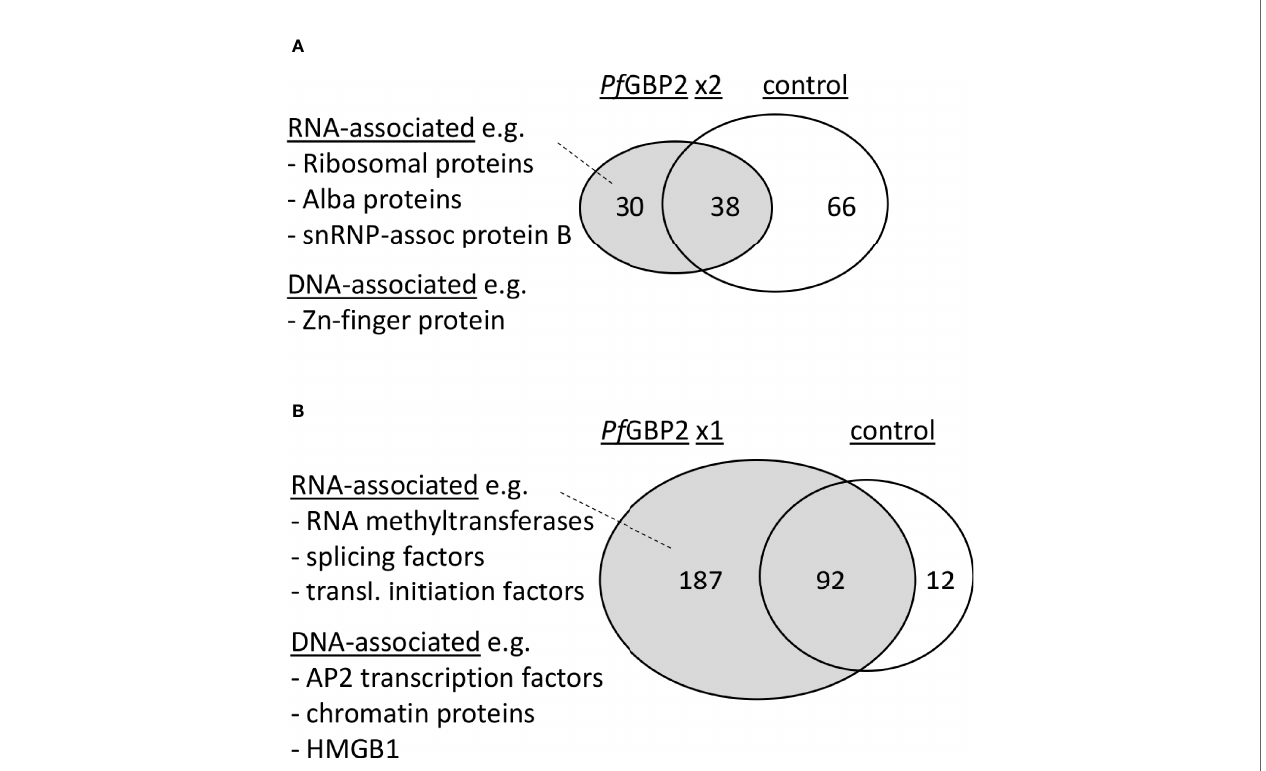
FIGURE 6 | Pf GBP2 interacts primarily with RNA-associated proteins. (A) Venn diagram showing the proportion of Pf GBP2-interacting proteins found reproducibly in duplicate experiments but absent from the control experiment, with examples of representative proteins. (B) Venn diagram showing the larger number of Pf GBP2- interacting proteins found in only one duplicate experiment, with examples of representative